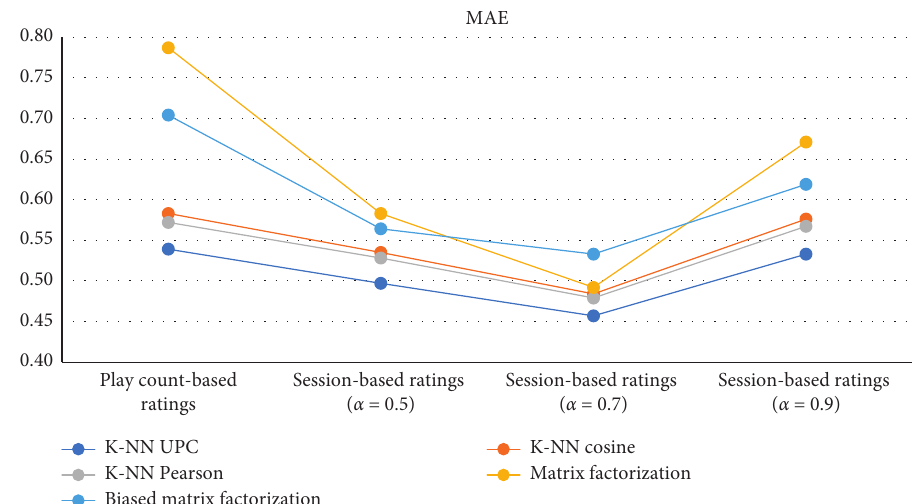
Figure 4: MAE of the CF methods tested in the study for ratings calculated in four different ways.